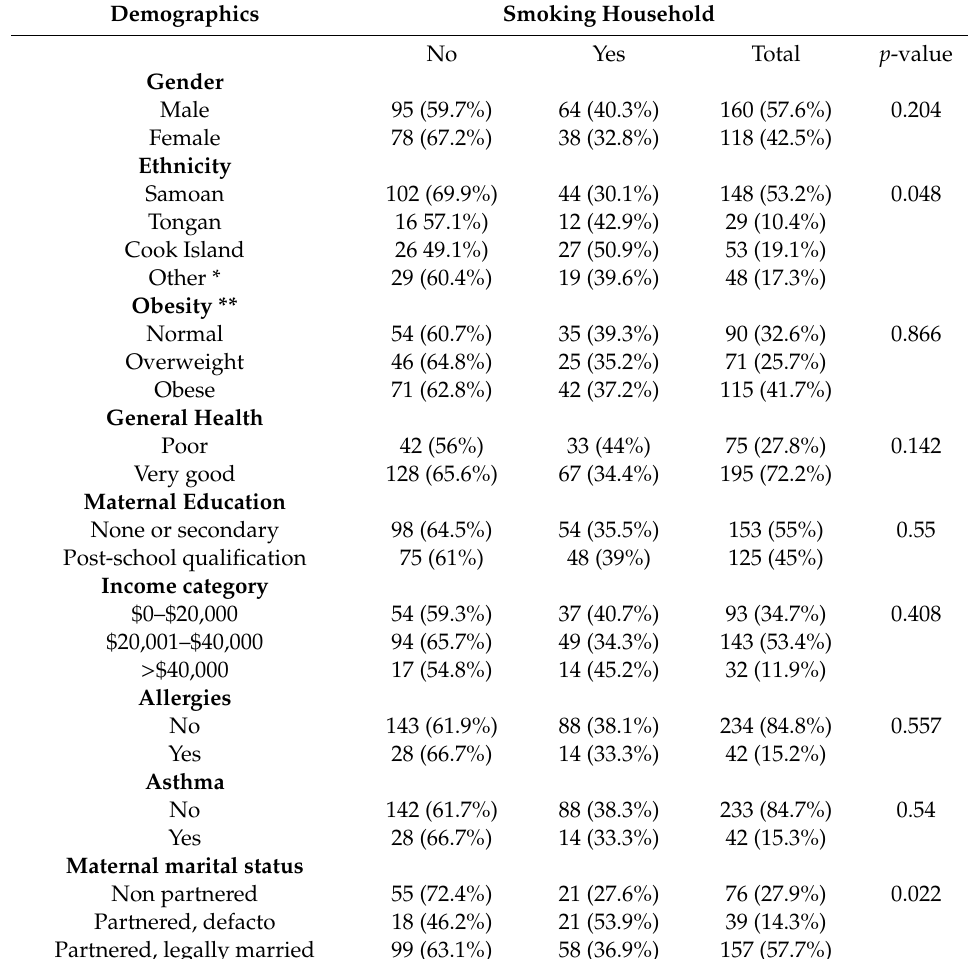
Table 1. Demographics status of children by smoking household.